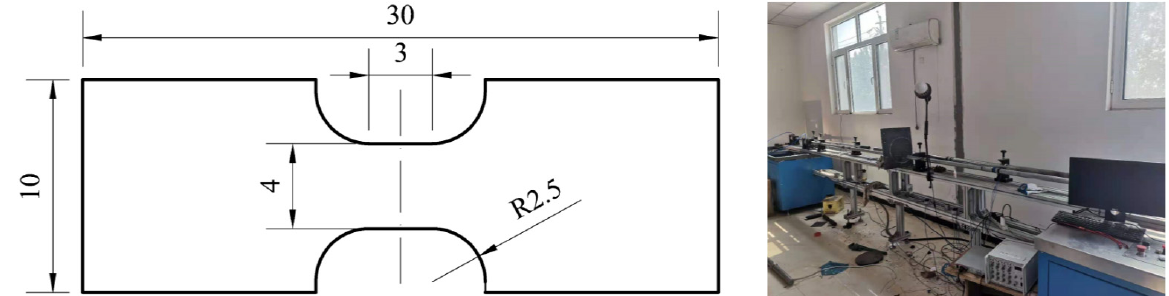
Figure 3. Split hopkinson tensile bar (unit/mm in figure).